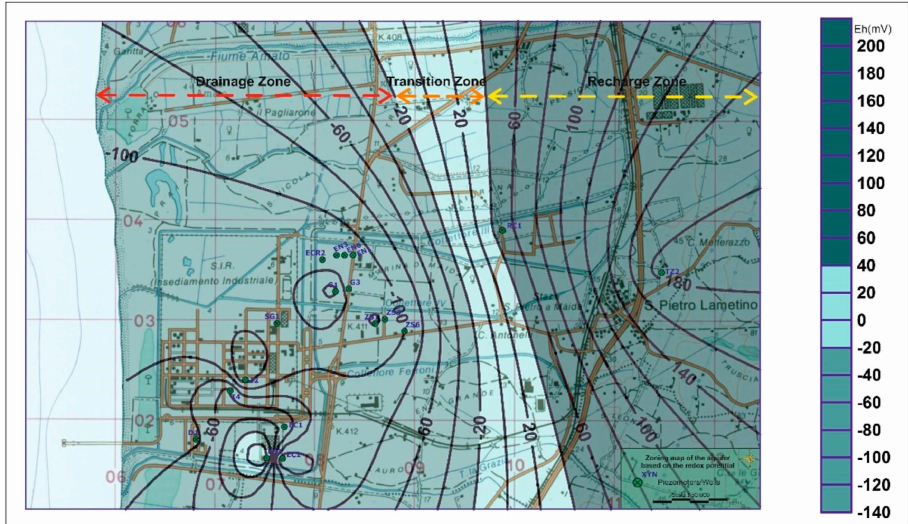
Figure 16. Aquifer Zoning Map Derived from Redox Potential Measured at Monitoring Points (Median Values) (Modified from